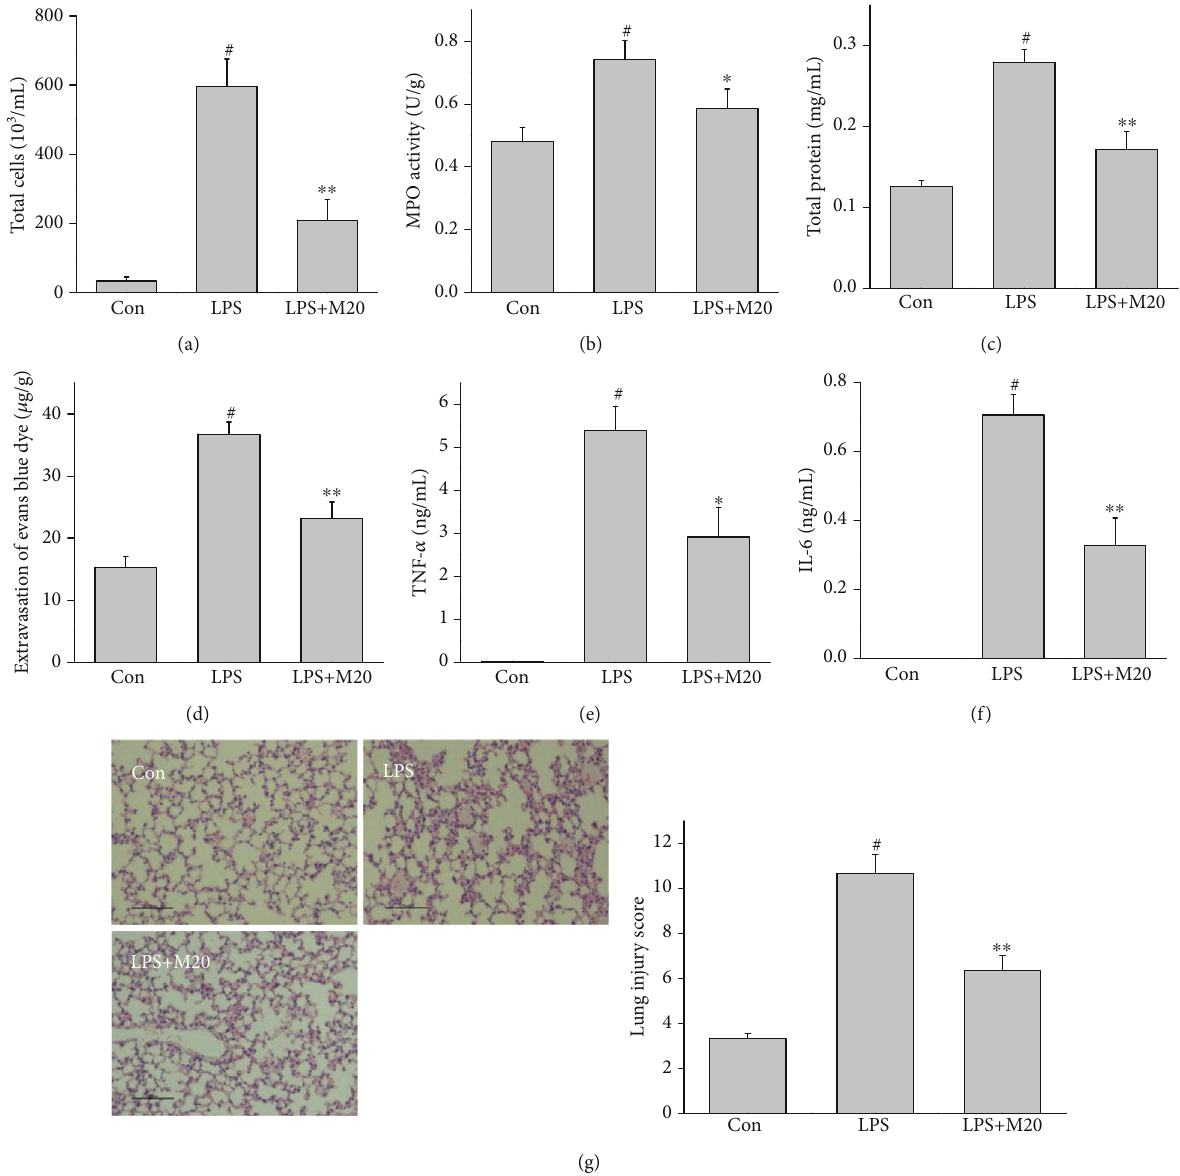
Figure 5: Therapeutic e ff ects of mibefradil on LPS-induced lung injury in mice. Mibefradil (20 mg/kg) was injected 30 min after LPS exposure, and mice were sacri fi ced 6 h after LPS exposure. The total cell counts (a) in BALF, MPO activities (b) in lung tissue, total protein concentration (c) in BALF, extravasation of Evans blue dye (d) in lung tissue, TNF- α (e) and IL-6 (f) levels in BALF, and pathological changes (g) in the lung were measured. All values are mean ± SEM ( n = 6 ). # p < 0 : 05 , compared with vehicle-treated control; ∗ p < 0 : 05 , signi fi cant compared with LPS alone; ∗∗ p < 0 : 01 , signi fi cant compared with LPS